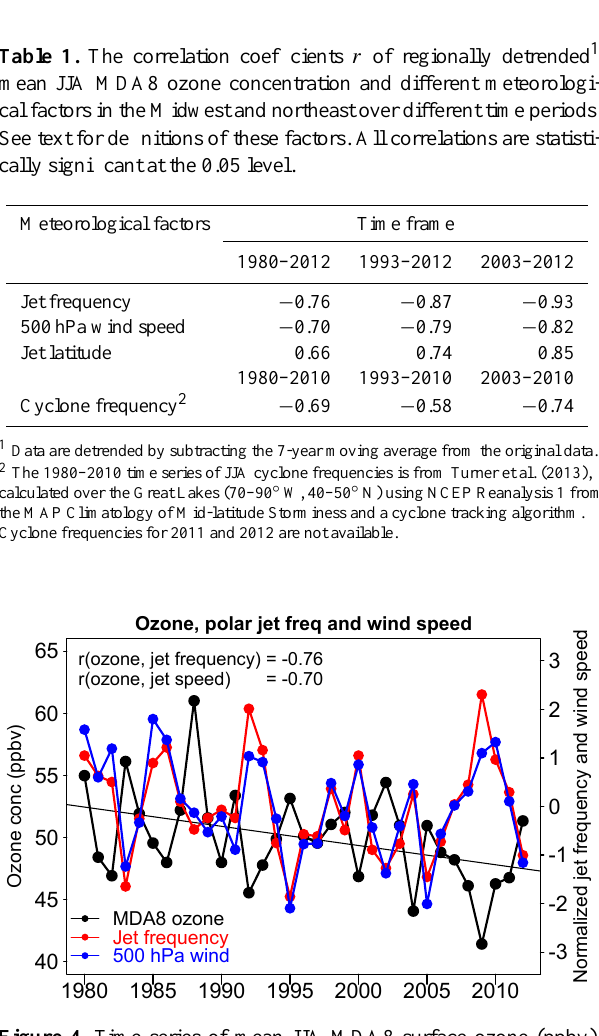
Figure 4. Time series of mean JJA MDA8 surface ozone (ppbv), normalized 500hPa wind speed, and polar jet frequency, averaged over the combined Midwest and northeast regions (Fig. 2). See text for further details on diagnosis of polar jet. The normalization of wind speed and jet frequency transforms the data to yield zero mean and unit variance. The black solid line denotes the linear trend of ozone over 1980–2012. The correlations of these jet metrics and MDA8 ozone when these data are detrended are